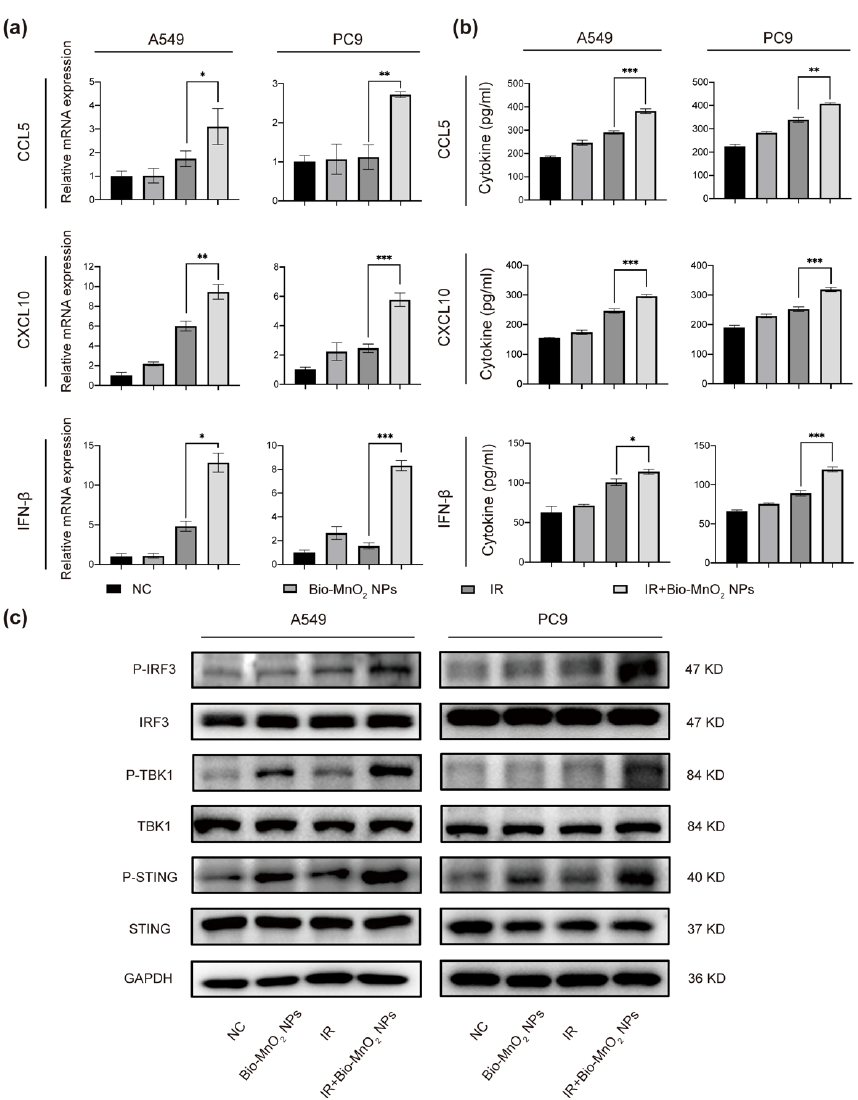
Figure 5. Bio-MnO 2 NPs plus radiation enhanced the activation of cGAS/STING signaling pathway. ( a ) The mRNA levels of C-C motif chemokine ligand (CCL) 5, CXC motif chemokine ligand (CXCL) 10 and interferon β (IFN- β ) after different treatments in A549 and PC9 cells. ( b ) The secretion of CCL5, CXCL10 and IFN- β detected by Enzyme-linked immunosorbent assay (ELISA) after different treatments in A549 and PC9 cells. ( c ) Immunoblotting of the classical cGAS/STING pathway proteins in A549 and PC9 cells. *, p < 0.05; **, p < 0.01; ***, p < 0.001. ICD involves exposure of calreticulin (CRT) in cell surface and the release of mediators containing nonhistone chromatin protein high-mobility group box 1 (HMGB1) and adenosine triphosphate (ATP), acts as a prominent pathway to stimulate the immune response to fight cancer [62]. It was recorded that either MnOx or RT can induce ICD, we therefore speculated that the combination of the two could elicit stronger ICD [48,63,64]. Consequently, we estimated the ability of Bio-MnO 2 NPs to synergize with RT to trigger ICD via metrics mentioned above. As shown, immunofluorescence revealed that radiation plus Bio-MnO 2 NPs manifested more CRT exposure than the free radiation